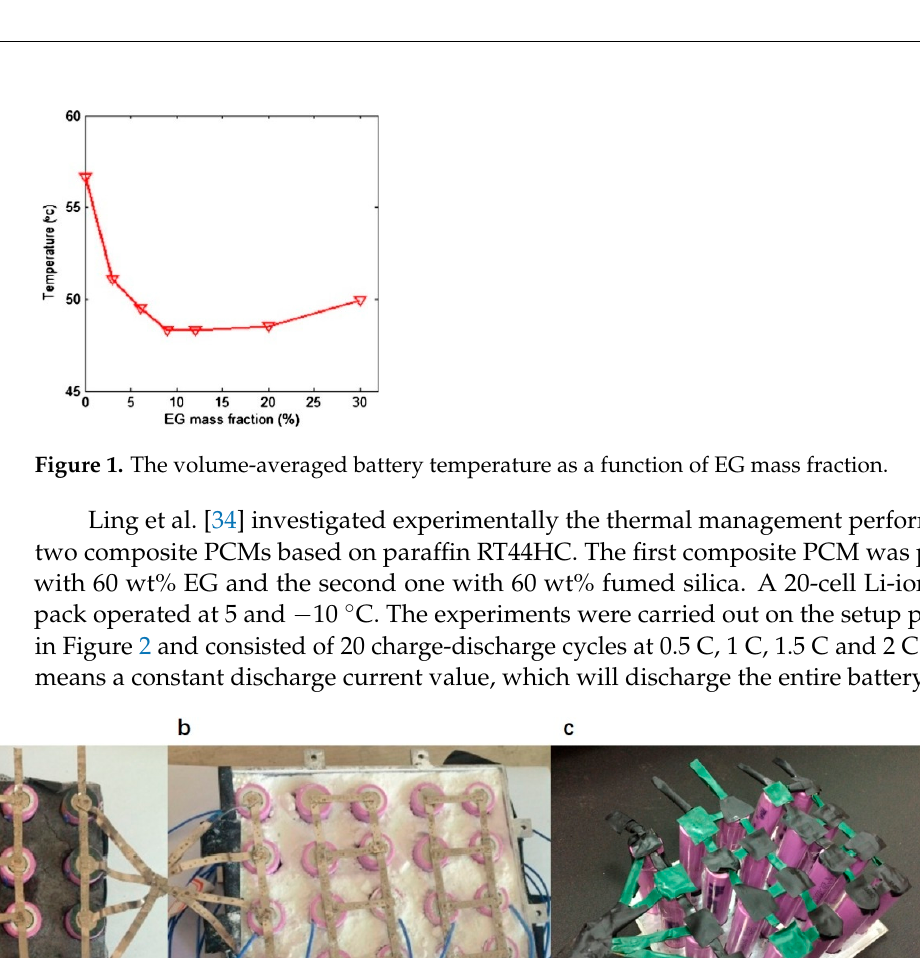
Figure 2. Li-ion battery packs: ( a )—60 wt% RT44HC/EG; ( b )—60 wt% RT44HC/fumed silica; ( c )— no PCM. Reproduced from [34] with permission from Elsevier.